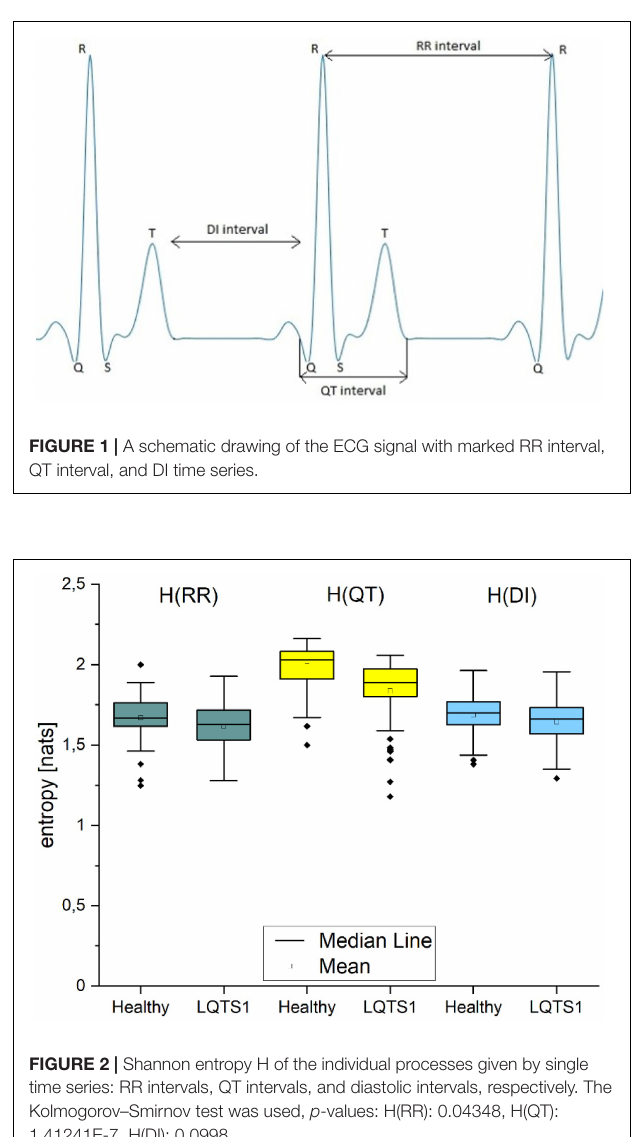
FIGURE 4 | Self-entropy of the processes: RR intervals, QT intervals, and diastolic intervals, respectively. p -Values: SE(RR): 0.00394, SE(QT): 4.91195E-10, SE(DI):